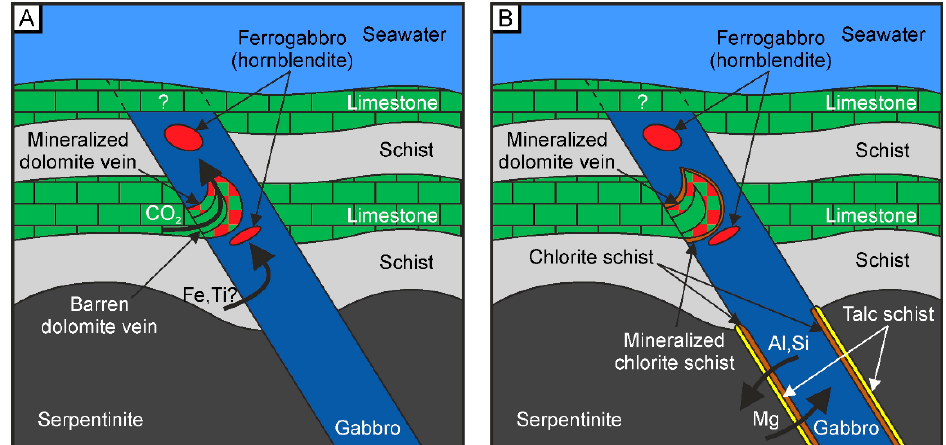
Figure 14. Schematic model of joint Fe-Ti-V mineralization, talc and chlorite schist formation, and carbonation in the fossil seafloor, now present as the ore prospect at the culmination of the Ż mijowiec Rib near Kletno. ( A ) The gabbro or diabase intrusion into the serpentinite and its sedimentary cover, composed of limestone and schist. The CO 2 -bearing fluids from the limestone, and probably also Fe- and Ti-bearing fluids from the schist, caused enrichment of the mafic melt in these compounds. The CO 2 introduction caused oxides crystallization and accumulation in the form of ferrogabbro (now present as hornblendite). The CO 2 -rich fluids caused gabbro and ferrogabbro carbonation leading to the dolomite veins formation; ( B ) A syn-intrusive or post-emplacement, extensive hydration in the seafloor environment involving both the gabbro (diabase) and serpentinite (possibly also sedimentary cover), which marginal zones were transformed into the chlorite schist and talc schist, respectively. The latter is now present as ornamental talc occurrence. Si and Al were derived from gabbro (diabase), whereas Mg from serpentinite (and possibly also carbonate sediments). Thick arrows indicate source and migration of Si, Al, Mg, Fe, Ti and CO 2 .